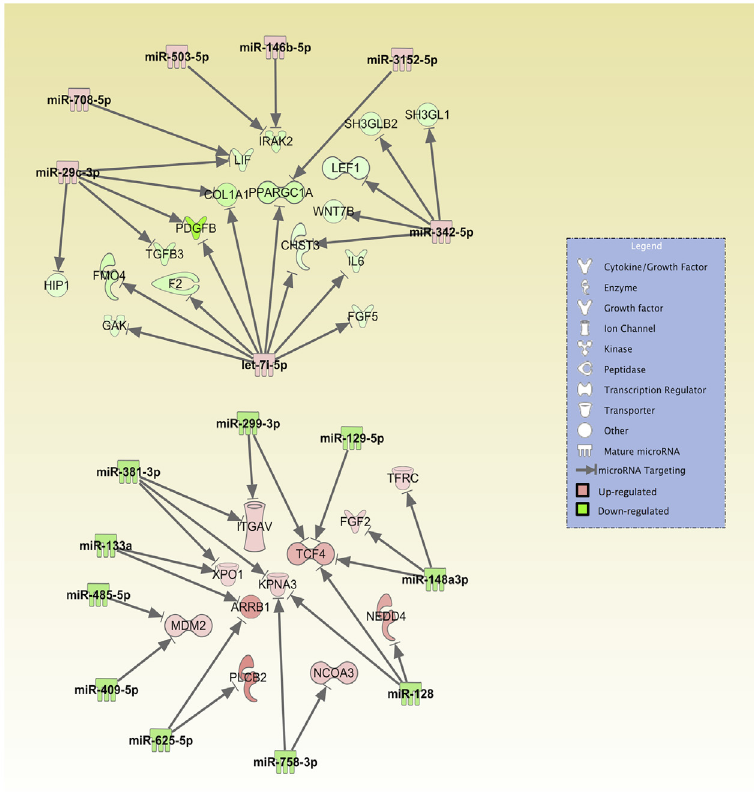
Fig 6. Implications of miRNA-mRNA pairs in Pathogen-Influenced Signaling. A total of 17 miRNAs and 28 mRNA targets are involved in the super pathway entitled ‘ Pathogen-Influenced Signaling ’ . Only experimentally validated and highly predicted targets are presented here. The top part shows the up- regulated miRNAs and respective down-regulated targets. The bottom part shows the down-regulated miRNAs and respective up-regulated targets. The intensity of colors represents the extent of the up- regulation or down-regulation, in red and green